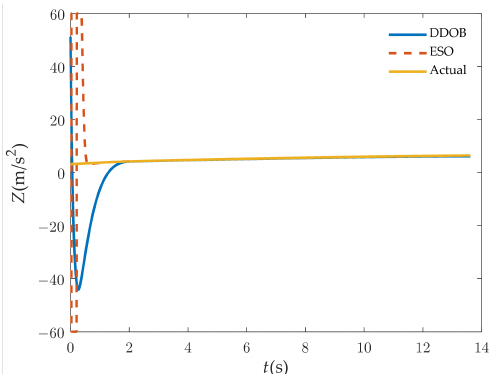
Figure 13. Estimation-performance comparison between DDOB and